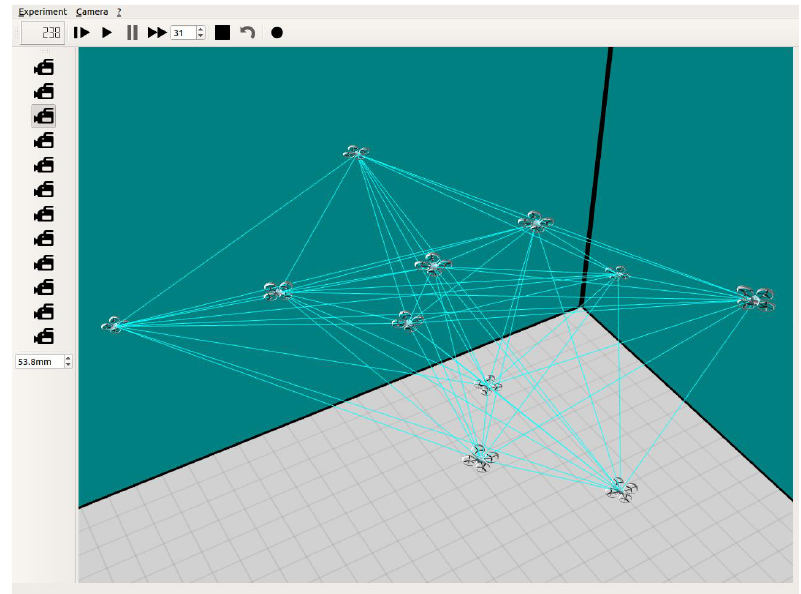
Figure 7. Snapshot of the ARGoS simulator showing eleven Spiri UAVs (swarm of ten plus the rogue drone) and their communication links.